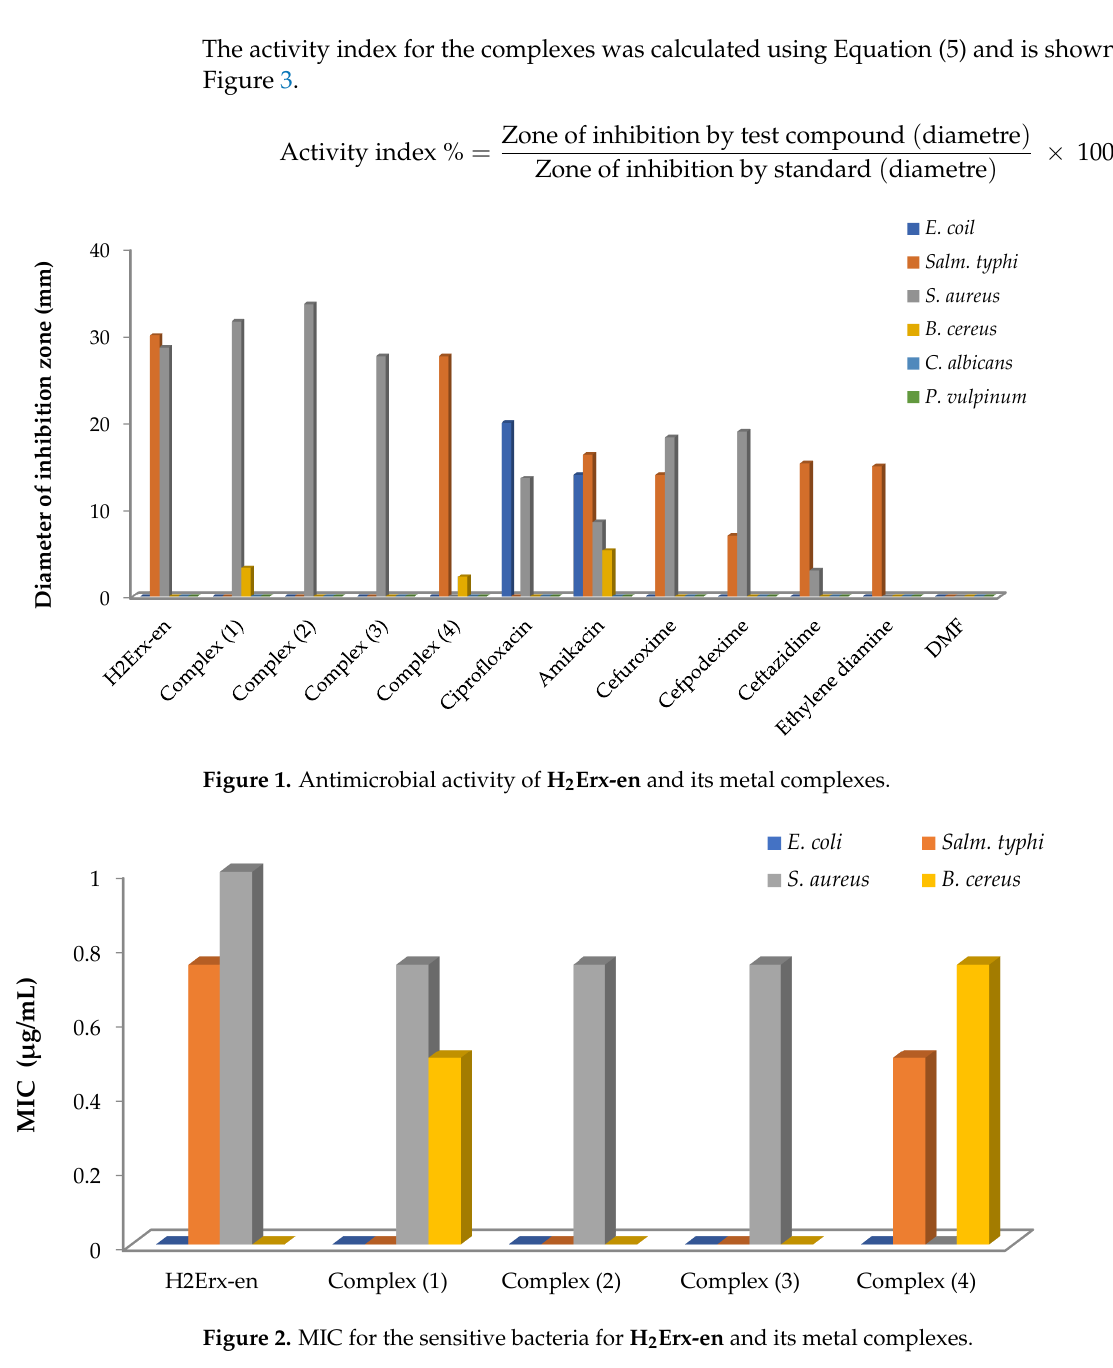
of S. aureus , the complex [Fe(Erx-en)(H 2 O) 2 ]Cl · 5H 2 O is more effective than previous work